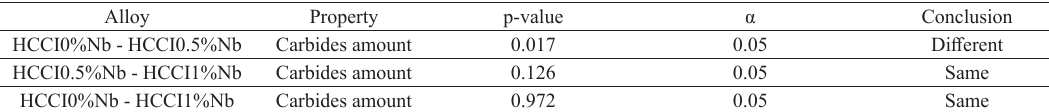
Table 6. Student’s t test for direct comparison between carbides amount. Alloy